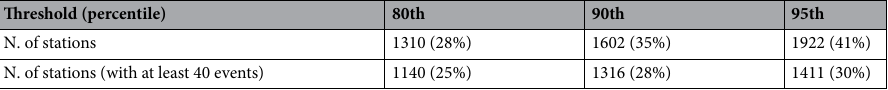
Table 1. The number of stations at different thresholds, and with at least 40 flood